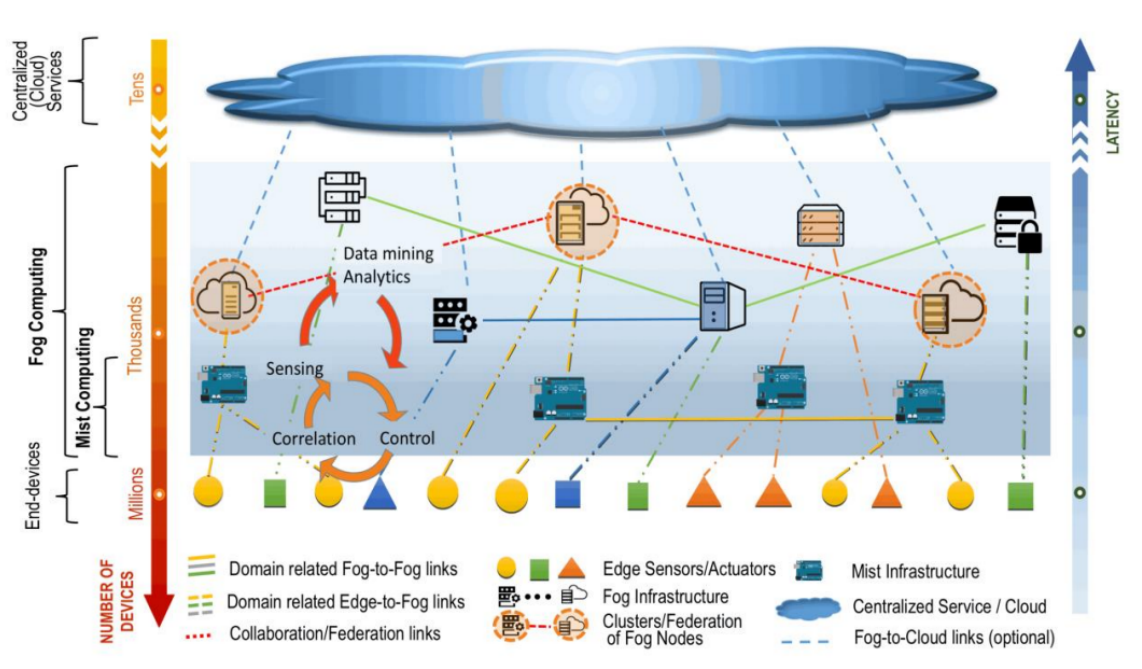
Figure 1. Fog computing supporting a cloud base for smart end-devices